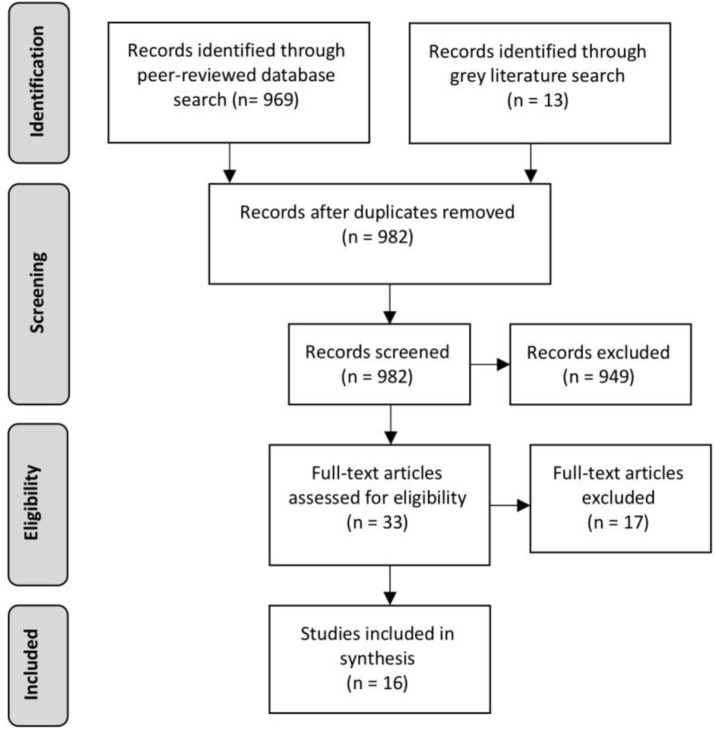
Prisma flow chart.